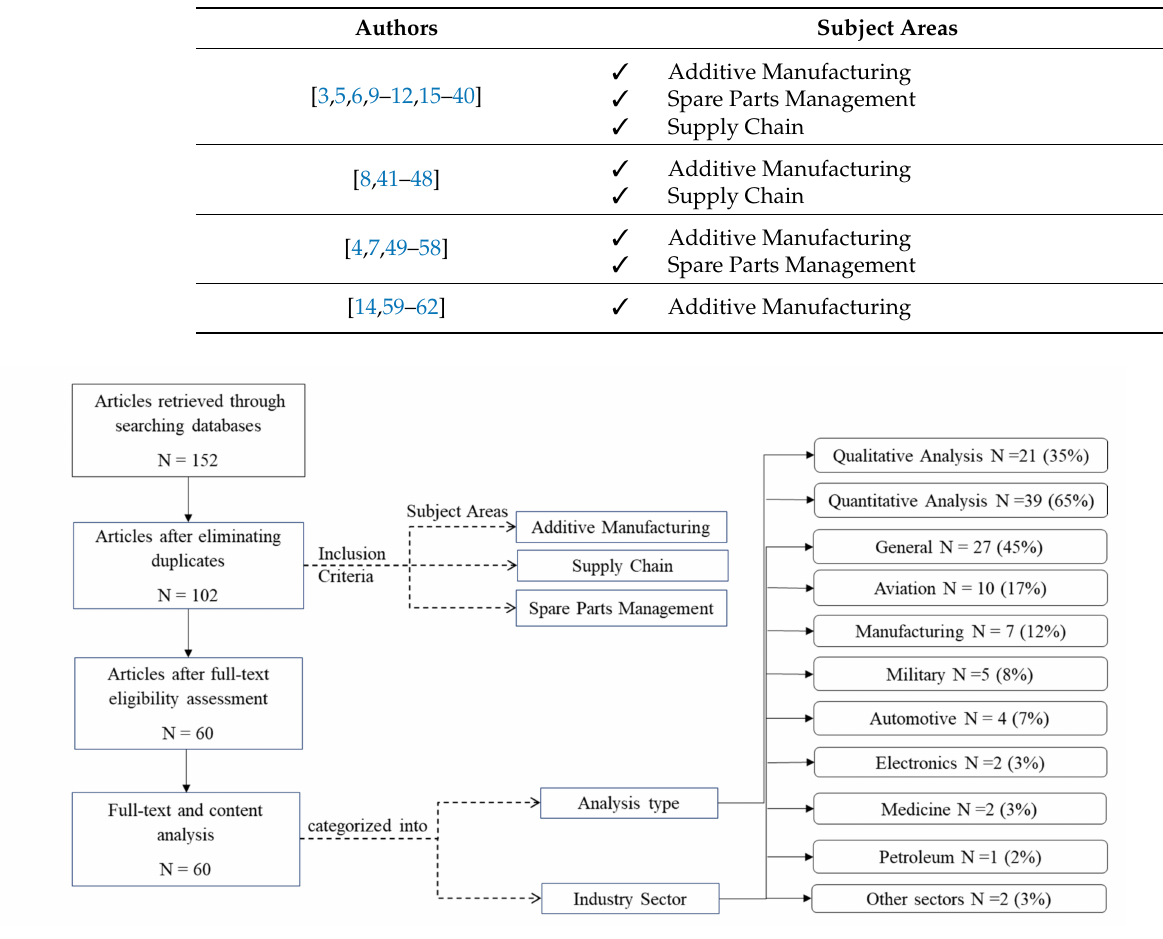
Figure 1. Review process